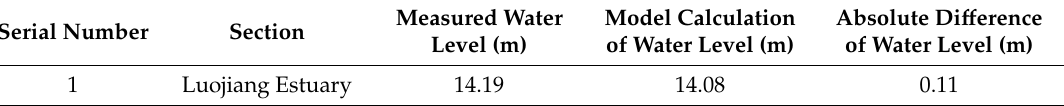
Figure 5. Water level comparing between the measured and calculated results of typhoon “Utor“ flood in 2013. Table 3. Comparison between the measured and calculated results of the typhoon “Utor” flood in